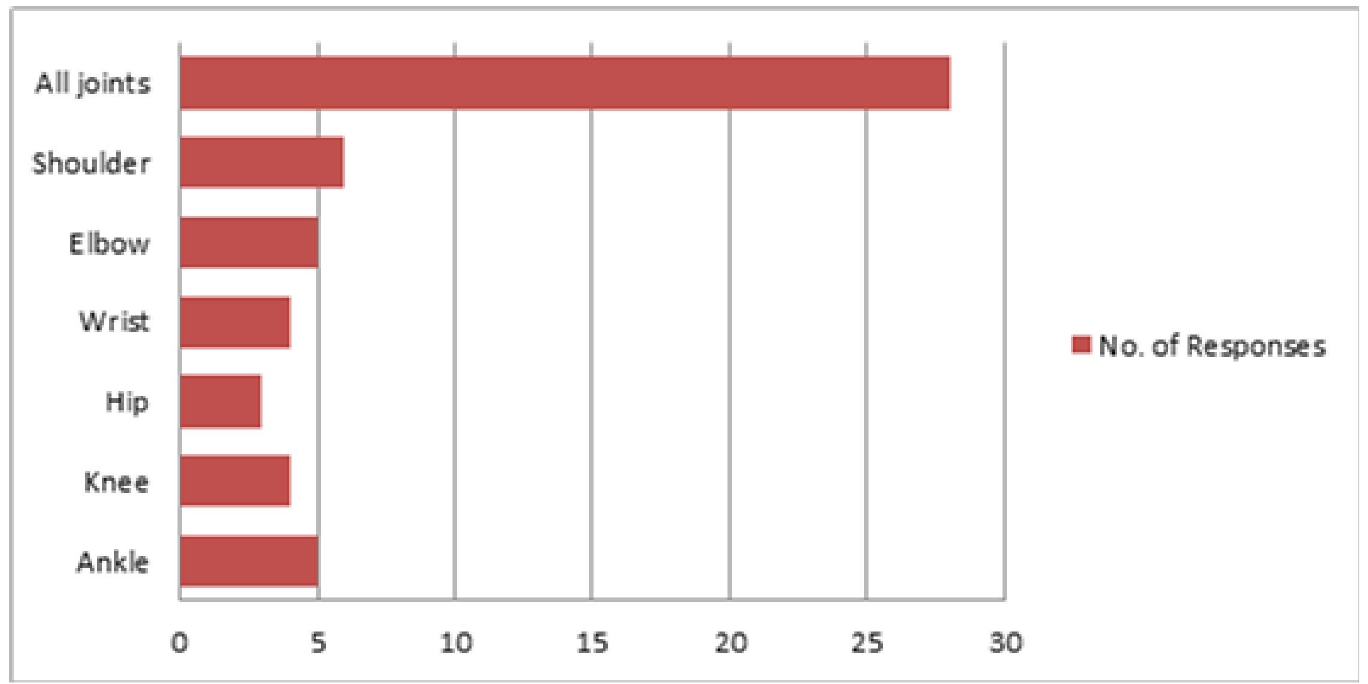
Fig 1. Joints assessed for passive limb range of motion reported by the 33 respondents.